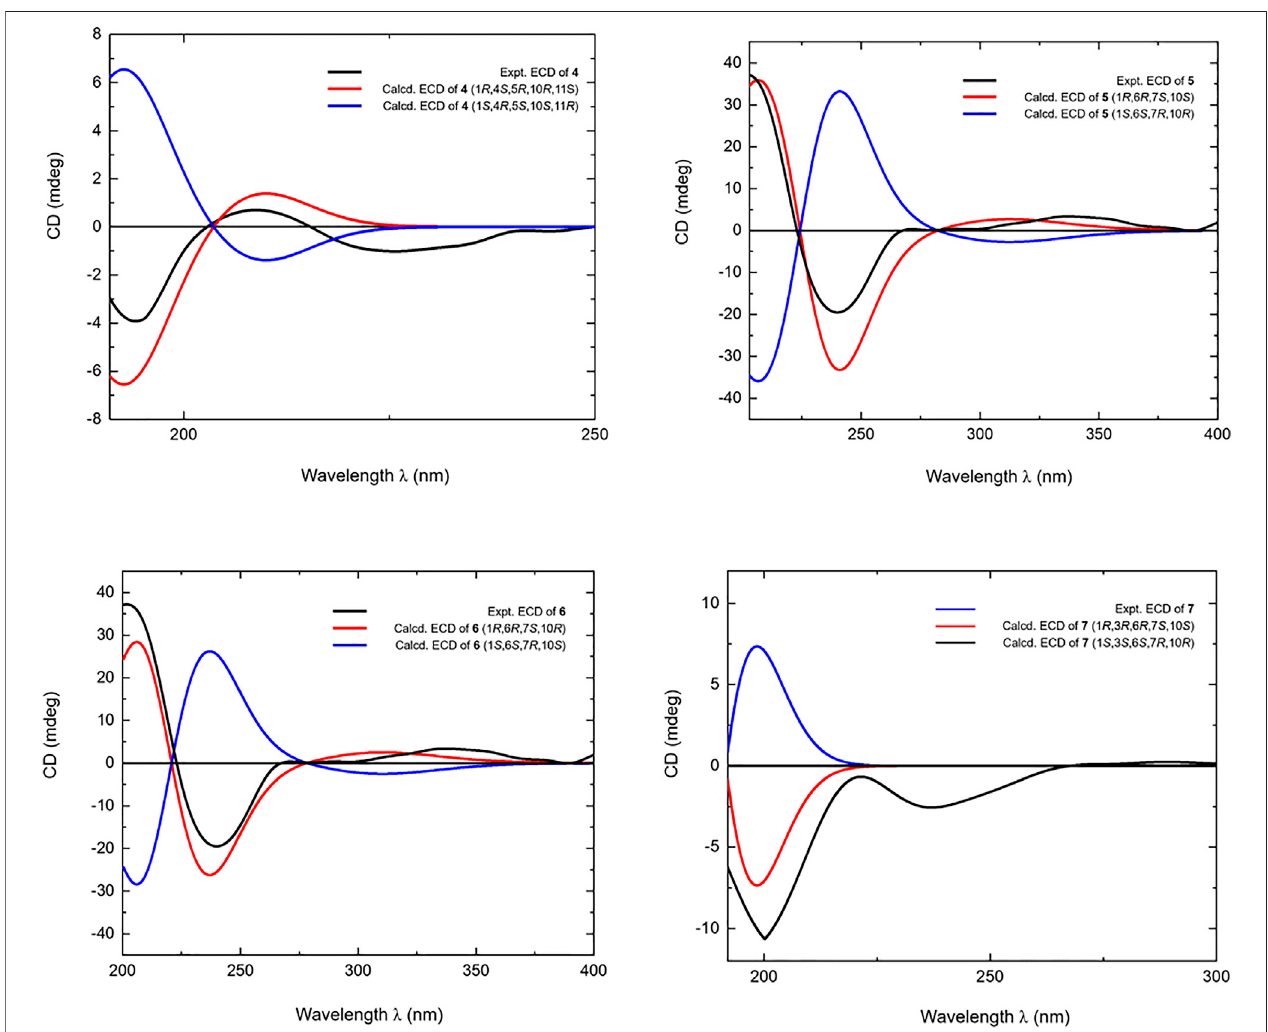
FIGURE 5 | Calculated and experimental ECD spectra of 4 – 7